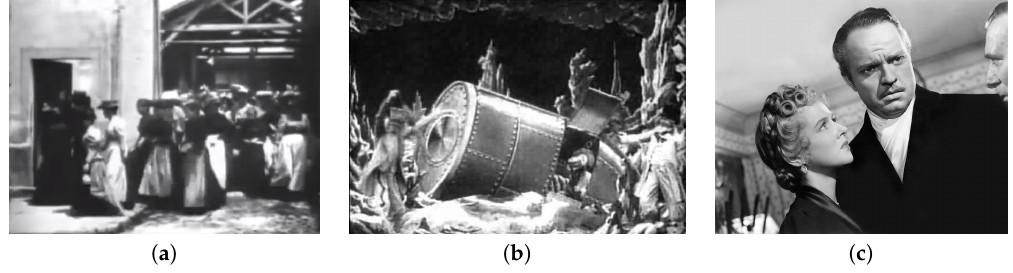
Figure 4. Technological developments in the art of filmmaking: ( a ) the first captured film, of workers leaving the Lumiere Brothers’ factory (1895); ( b ) George Méliès’ 1902 A Trip to The Moon filmed like a stage play but with fantastical special effects; ( c ) Citizen Kane, which used numerous experimental camera and lens effects to tell the story. Public domain